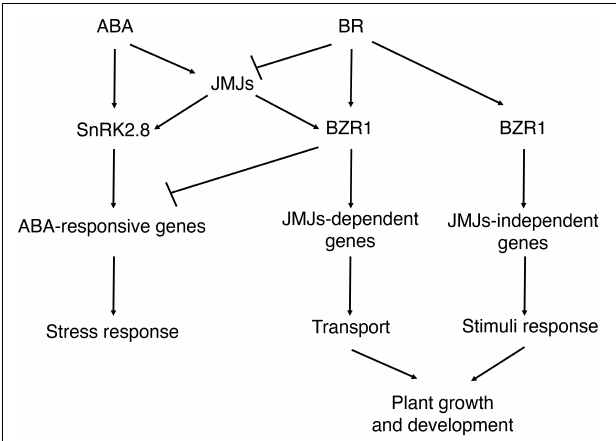
FIGURE 7 | Proposed models for the interaction between ABA and BR during post-germination stage. ABA inhibits the later growth of the seedling. BR promotes the later growth of the seedling. JMJ-dependent and JMJ-independent pathway modulate growth arrest upon perception of ABA and BR signals